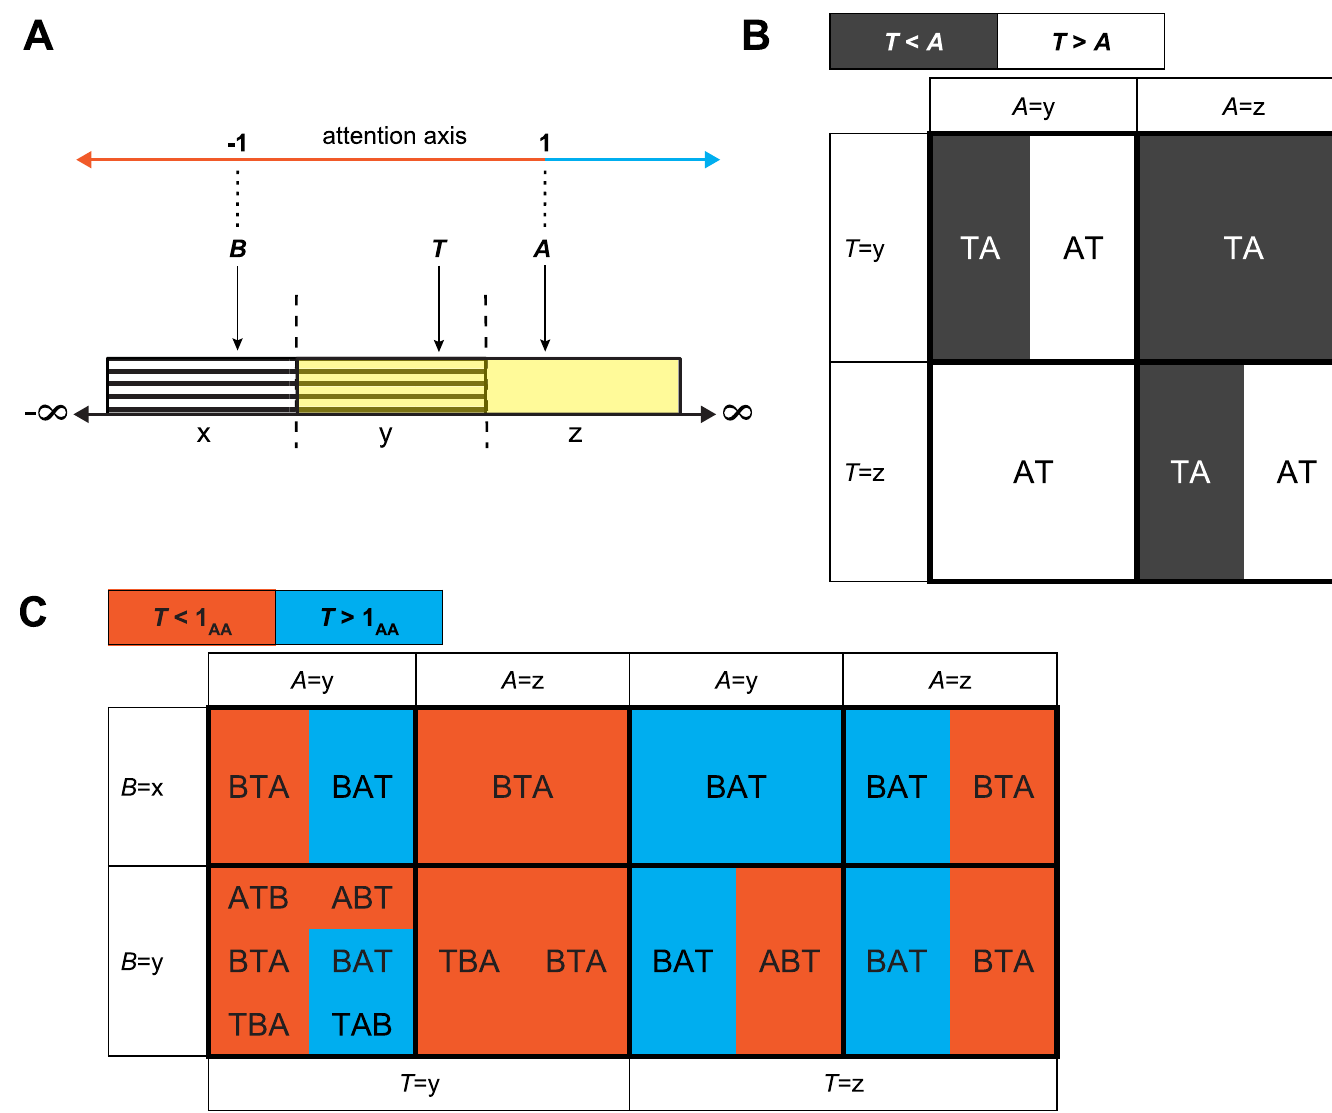
Fig 1. Attention axis construction and outcomes. (A) Schematic of two overlapping uniform distributions (hatched and yellow). Samples A and T are always drawn from the yellow distribution and can be located in range y or z. Sample B is drawn from the hatched distribution and can be located in range x or y. Samples A and B are used to construct an attention axis, which is normalized to A = 1 and B = -1. (B) Representation of possible outcomes and probabilities given samples A and T only. Fill colors show probabilities of sample T being less (black) or greater (white) than A . Unbiased sampling leads to equal total areas for black and white cells. (C) Representation of all possible outcomes for the value of T on the attention axis. Same conventions as B, except probabilities are relative to 1 on the attention axis. The excess of orange relative to blue indicates that sampling is biased towards values of T that are less than 1 on the attention